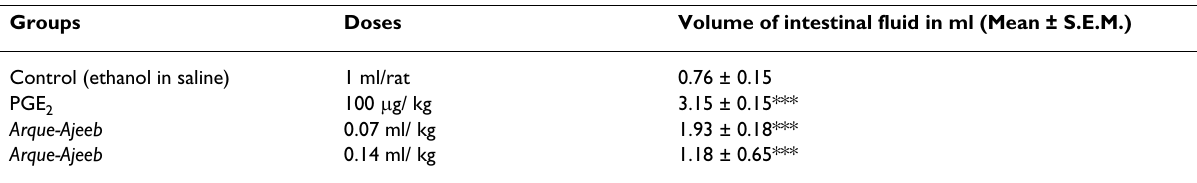
Table 3: Effect of AA on PGE 2 -induced small intestine enteropooling Groups Doses Volume of intestinal fluid in ml (Mean ± S.E.M.) Control (ethanol in